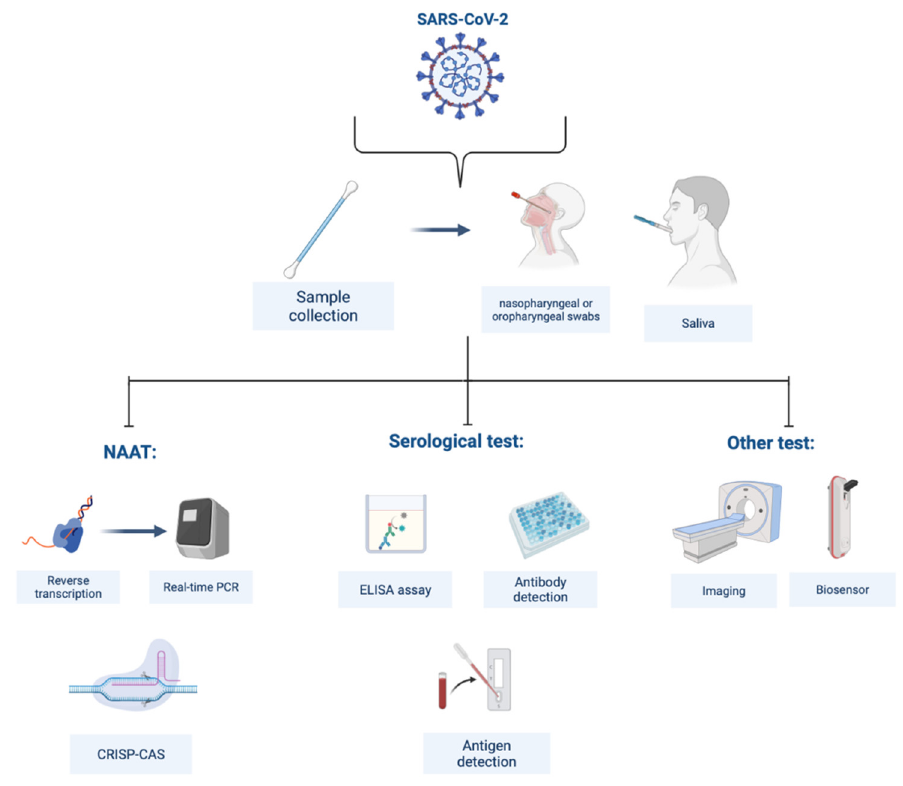
Figure 2. Sars-COV-2 virus diagnosis methods.